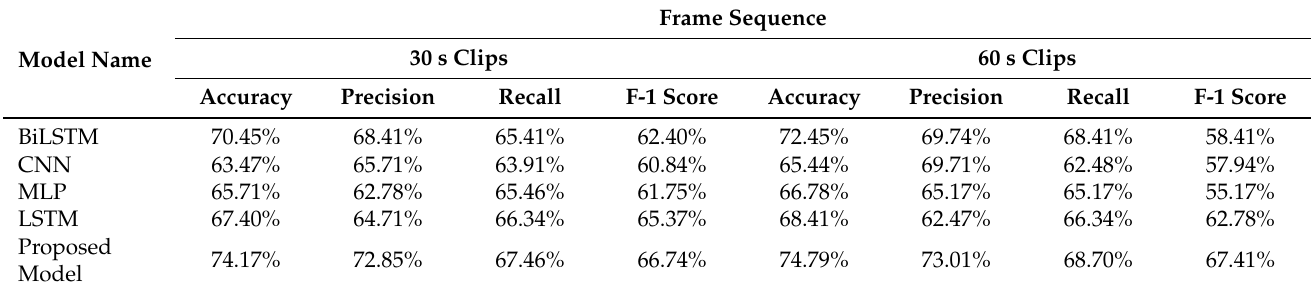
Table 6. Performance comparison of the proposed system with different models and video lengths.